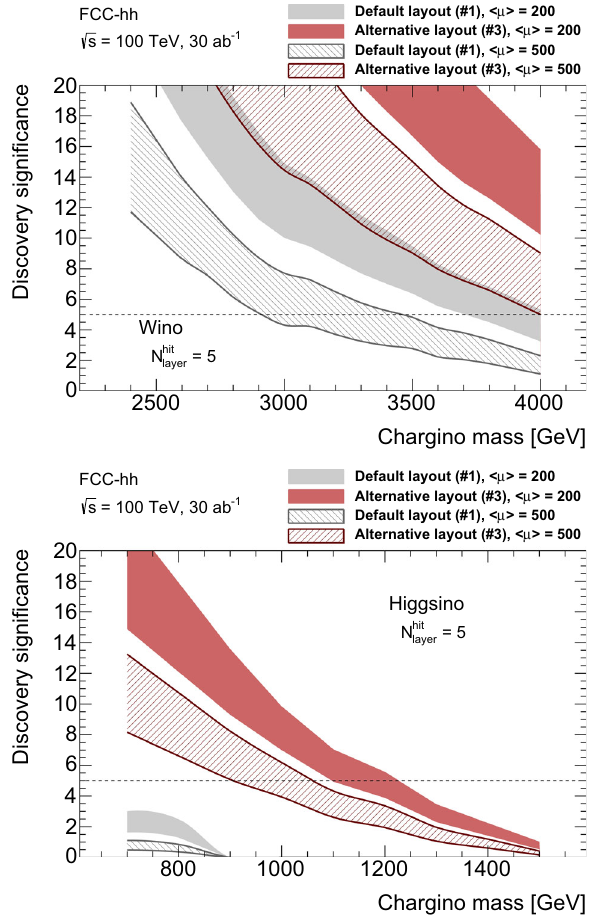
Fig. 5 Expecteddiscoverysignificanceforthewino(top)andhiggsino (bottom) models with 30 ab − 1 with the requirement of N hit grey (red) bands show the significance using the default (alternative) layout #1 (#3). The difference between the solid and hatched bands corresponds to the different pileup conditions of (cid:8) μ (cid:9) = 200 and 500. The band width corresponds to the significance variation due to the two models assumed for soft QCD processes